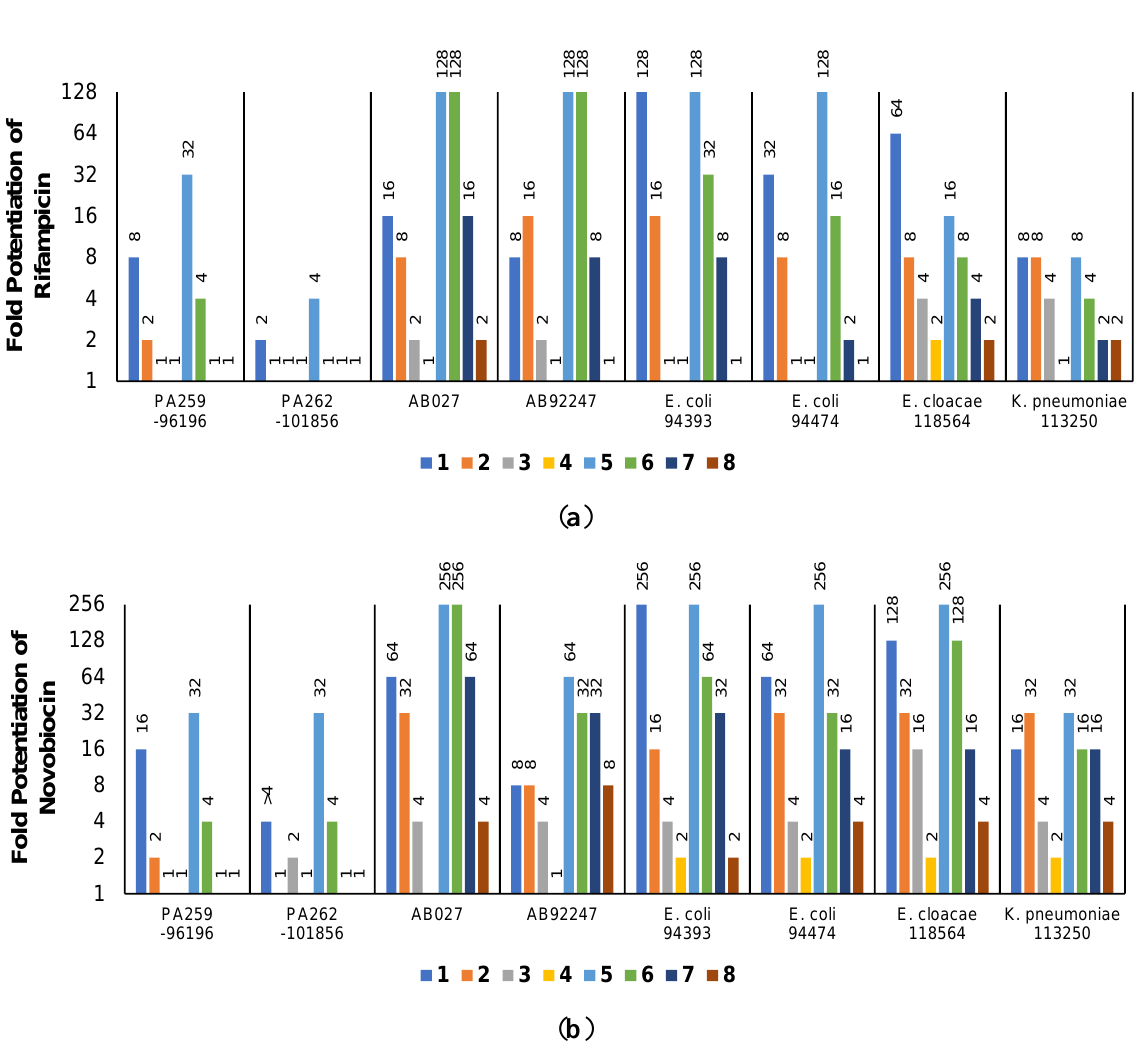
Figure 3. Potentiation of ( a ) RIF and ( b ) NOV by 6 μ M UTBLP against a panel of MDR and car- bapenem-resistant GNB isolates.